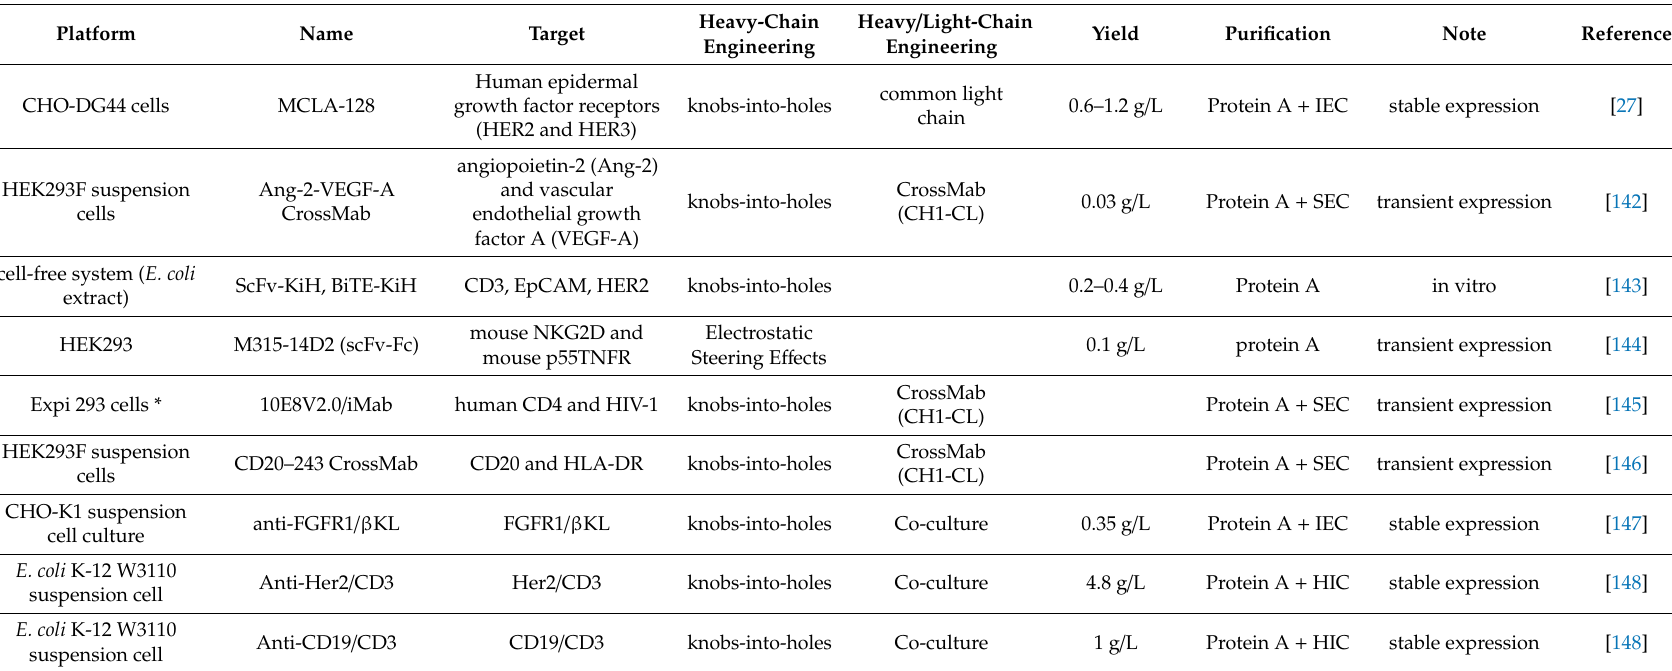
Table 2. Examples of the expression of IgG-like bispecific antibody molecules in various